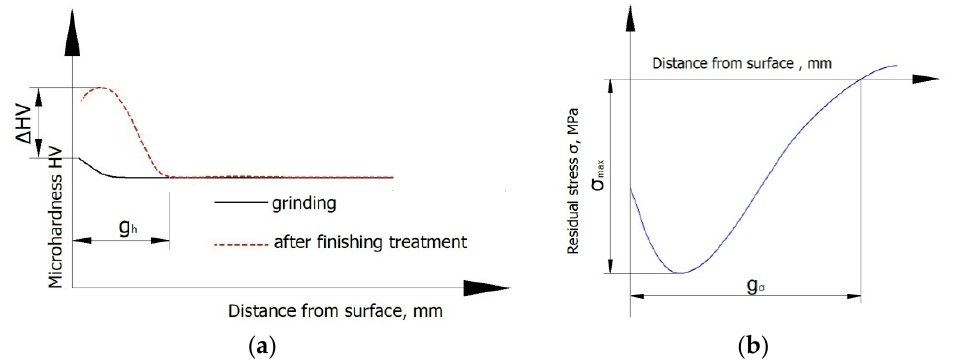
Figure 4. Methodology for determining: ( a ) microhardness increase Δ HV and hardened layer thickness g h ; ( b ) the maximum absolute value of the compressive residual stresses σ max and depth of incidence of the residual compressive stress g σ .